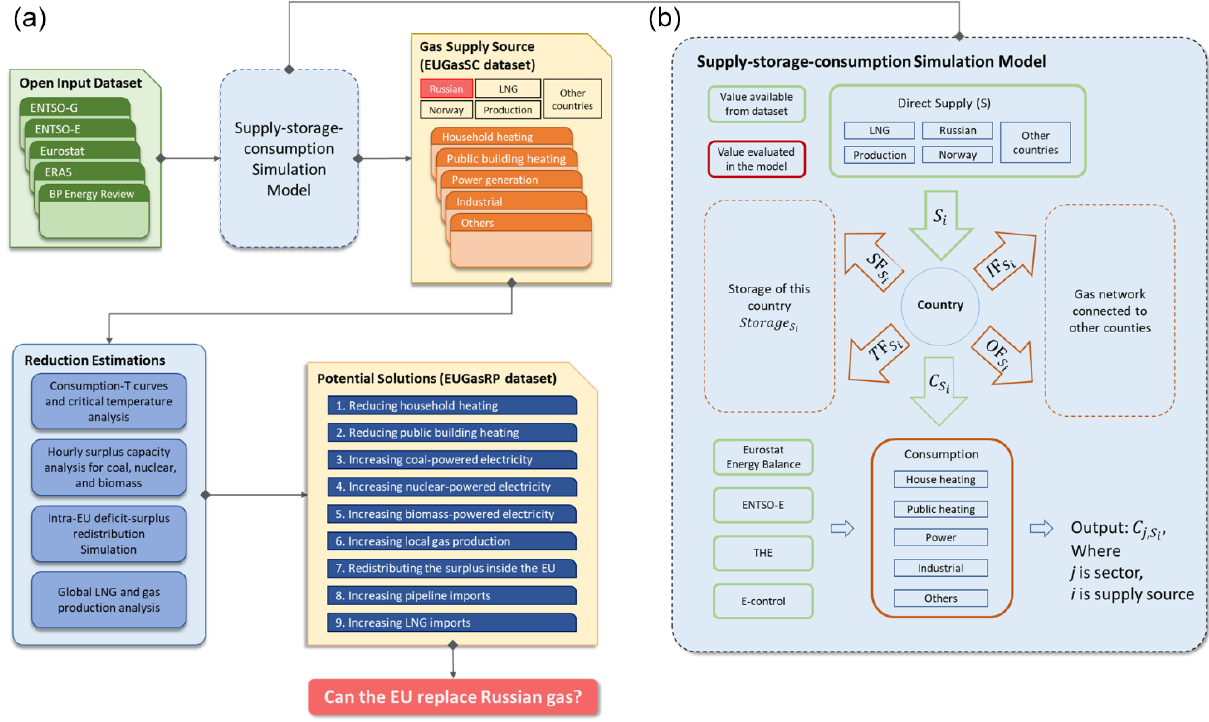
Figure 1. Workflow and model concept of this study. (a) The workflow of this study, including the input datasets, their usage in models, and the output datasets. (b) The concept of the supply–storage–consumption simulation model used in this